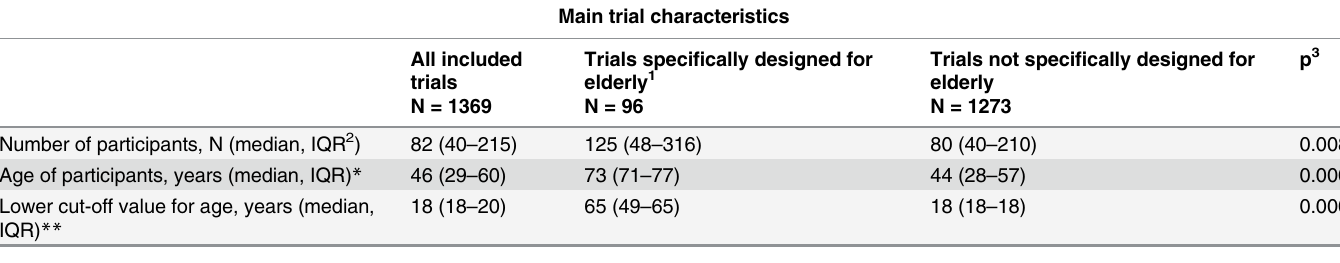
Table 1. Main trials characteristics of 1369 included